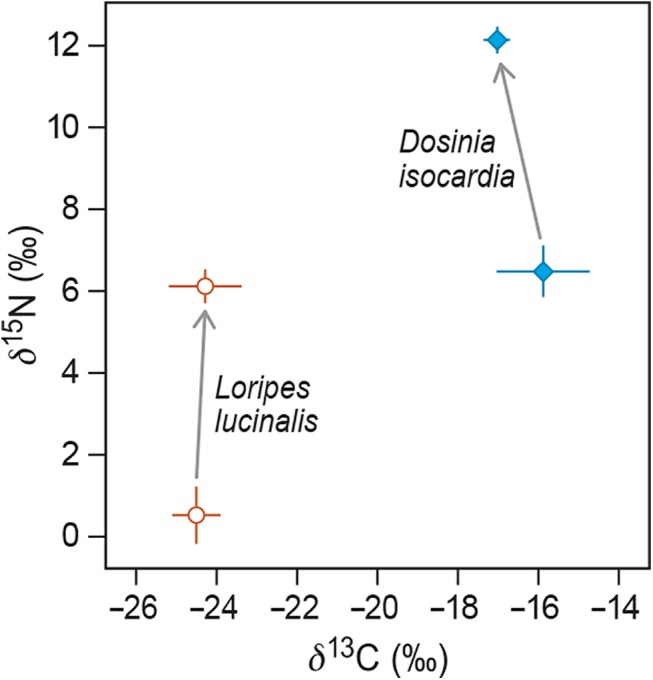
Discrimination of δ
13C and δ
15N from food (at arrow base) to plasma (at arrow head), plotted for the two diet groups separately.Bars represent 95% confidence intervals.